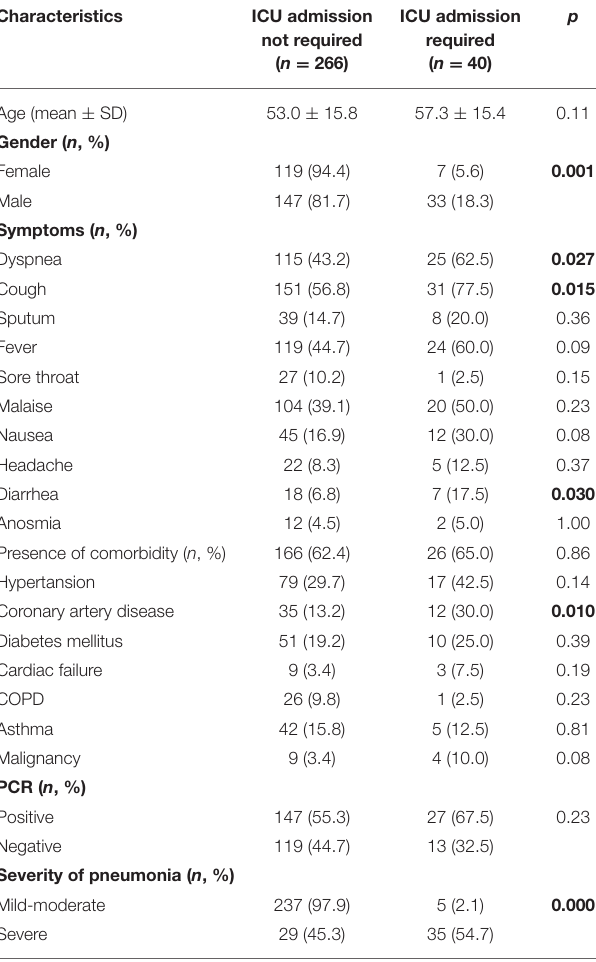
TABLE 1 | Comparison of patients according to intensive care unit transfer with demographic and clinical features on admission. Characteristics